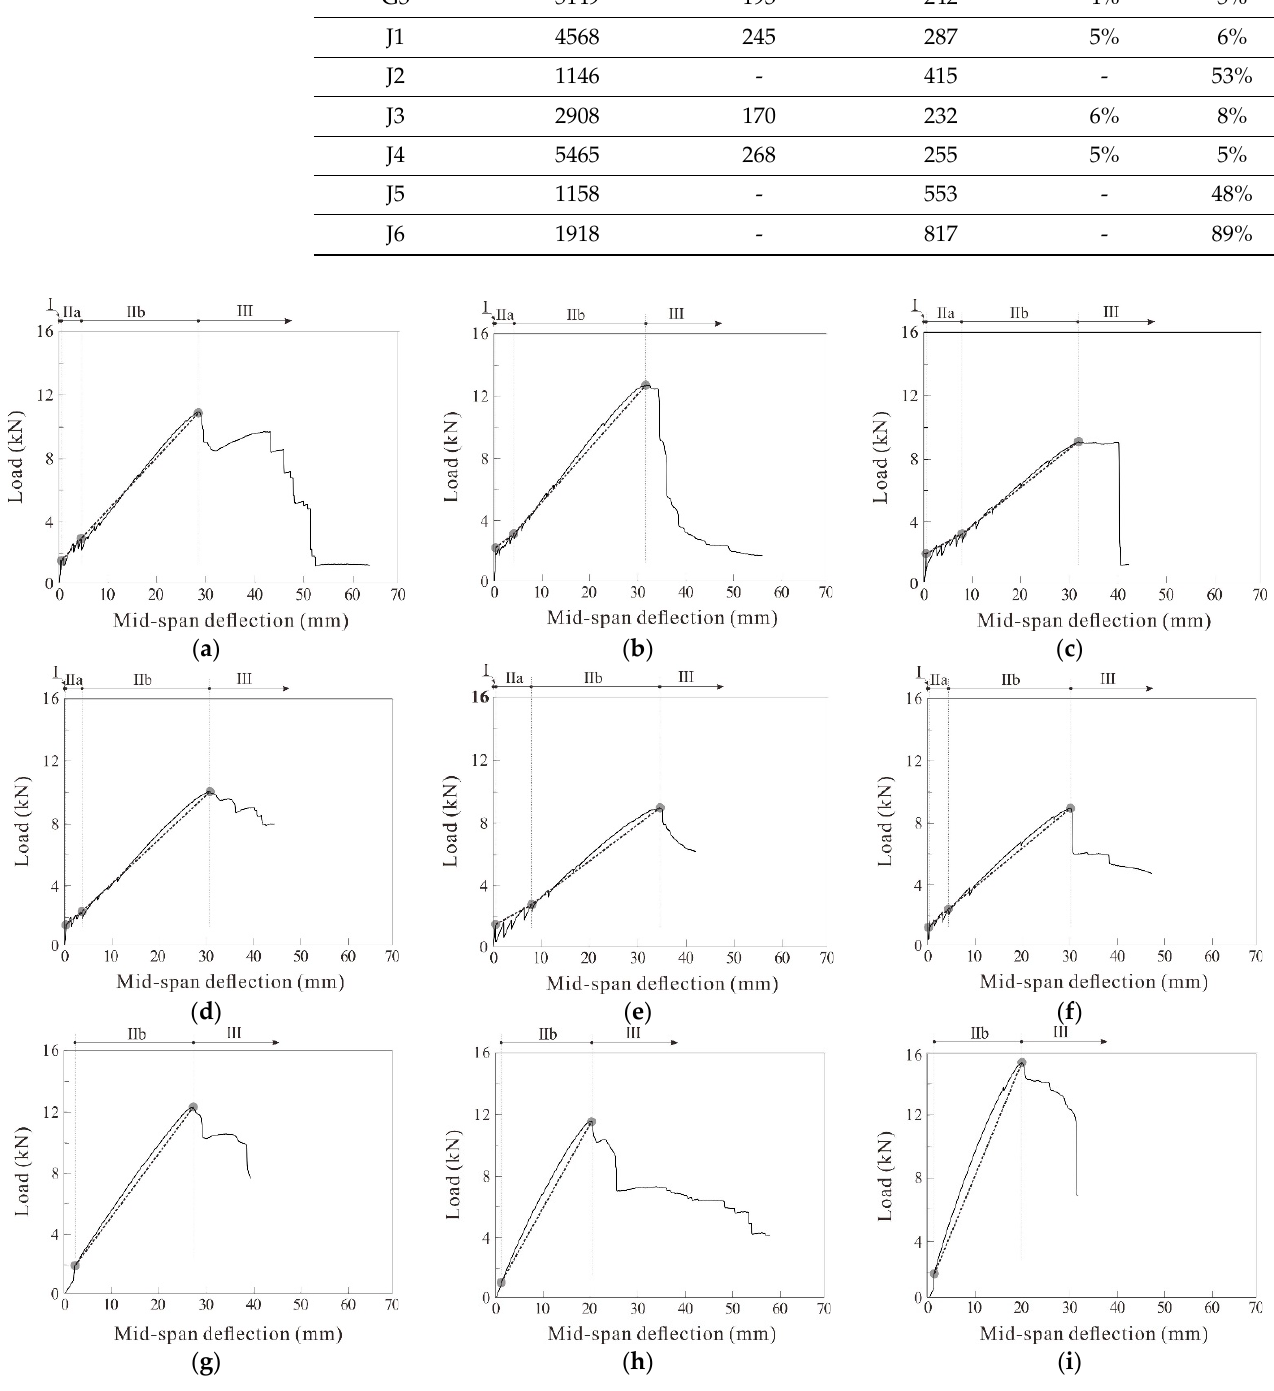
Figure 11. Stiffness in the crack formation and stabilization stages for the specimens: ( a ) G1; ( b )